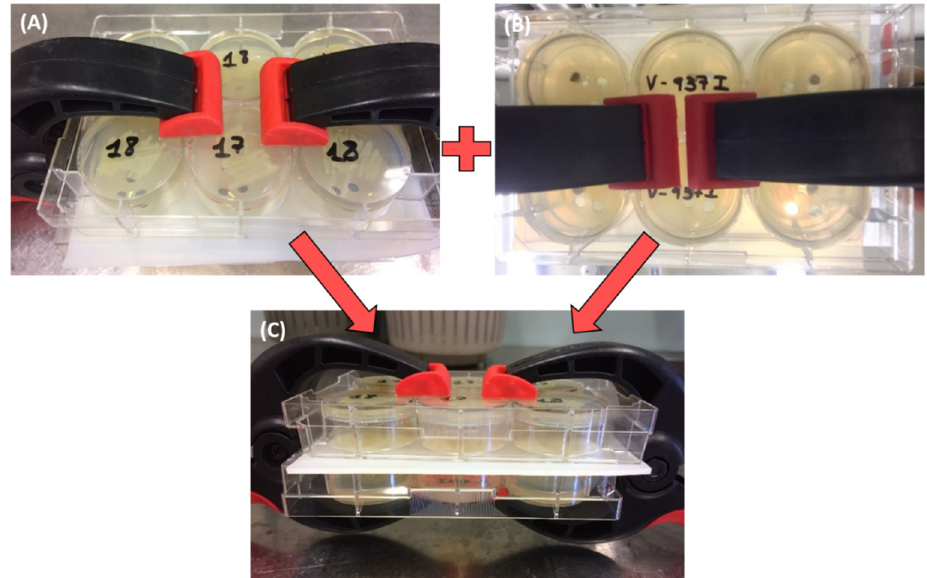
Figure 2. Evaluation of the ability of olive root bacterial endophytes to inhibit the mycelial growth of Verticillium dahliae V937I using the Two Clamp VOCs Assay (TCVA). Panel ( A ) shows the bacterial cultures placed on the top. Panel ( B ) shows the mycelial plugs of V. dahliae placed on the bottom. Panel ( C ) shows both plates (fungus and bacteria) connected by the perforated silicone foil and fixed with clamps.